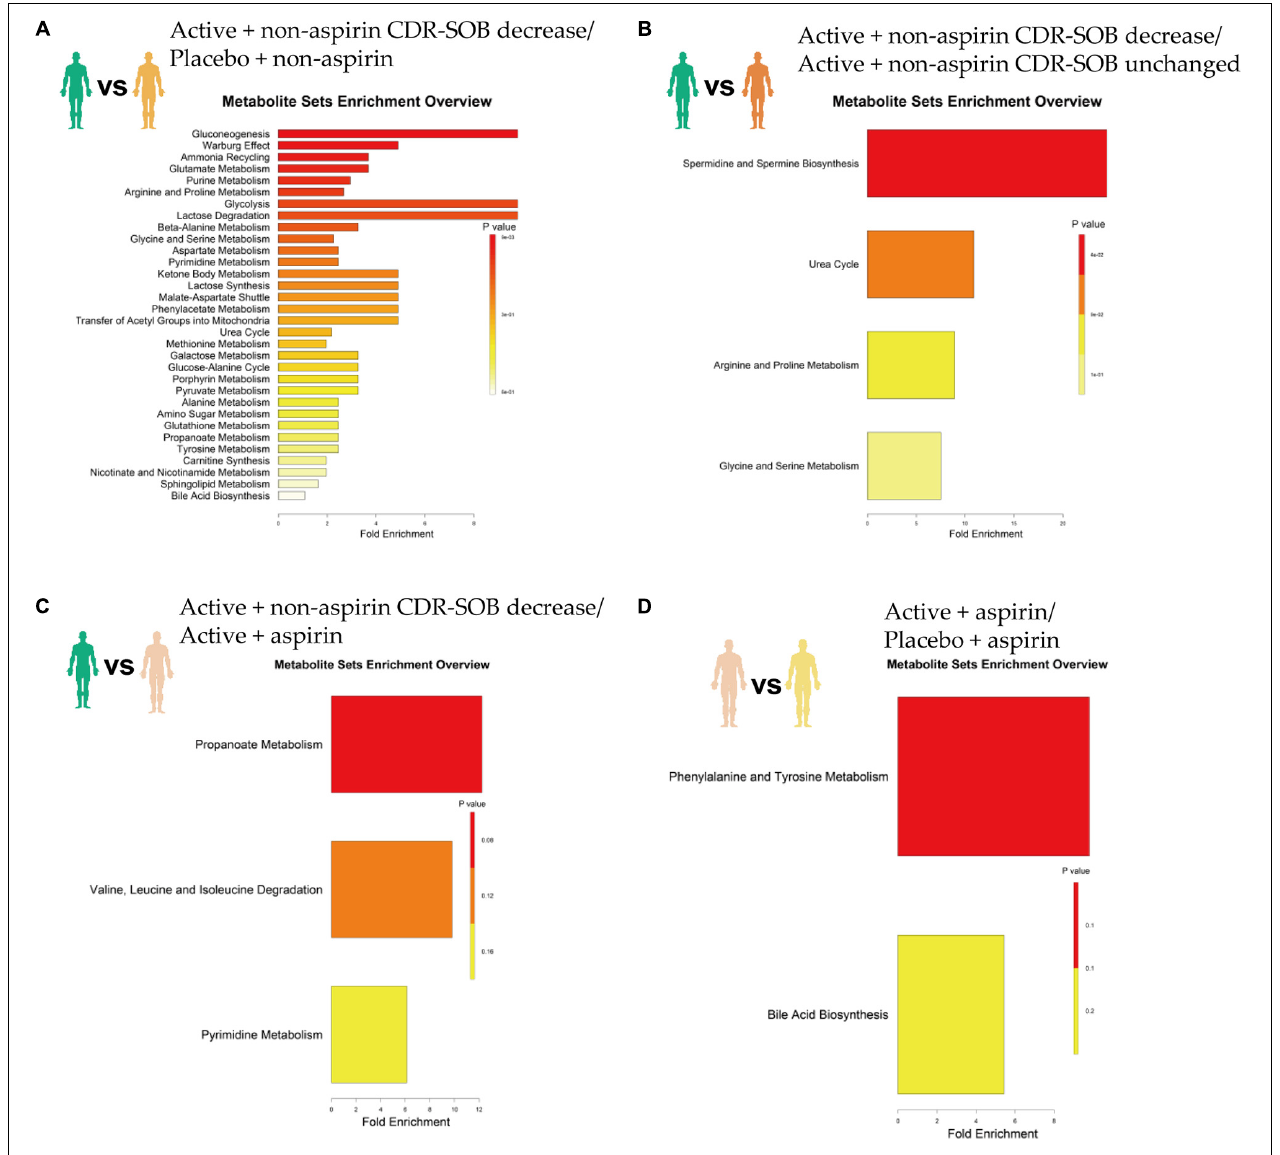
FIGURE 3 | Top altered metabolic pathways based on metabolome changes at 24-month in selected pairwise comparisons of clinical groups, which included (A) active B vitamin supplementation in non-aspirin users with reduction in CDR-SOB relative to non-aspirin users on placebo; (B) active B vitamin supplementation in non-aspirin users with reduction in CDR-SOB relative to those without changes in CDR-SOB; (C) active B vitamin supplementation in non-aspirin users with reduction in CDR-SOB relative to active B vitamin supplementation in aspirin users; (D) active B vitamin supplementation in aspirin users relative to aspirin users on